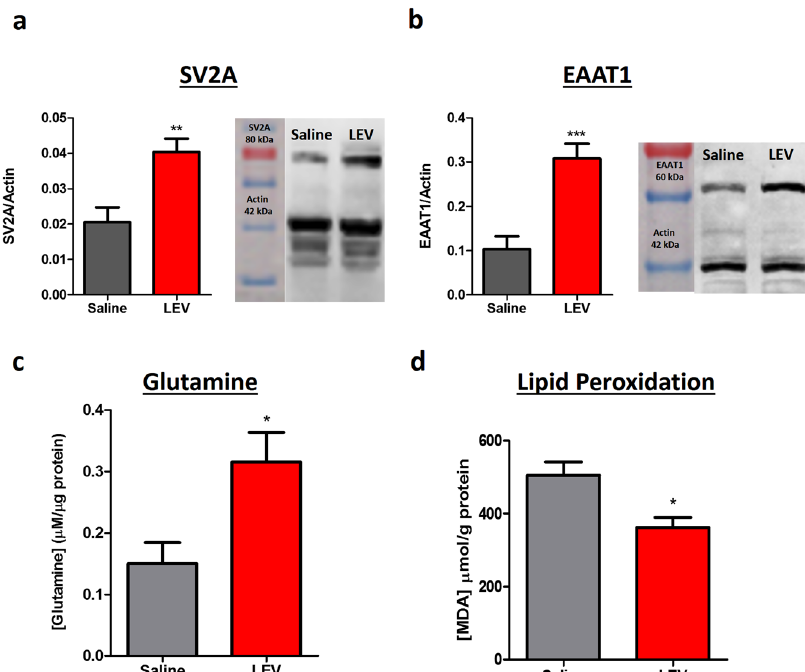
Fig. 3 LEV treatment promotes neuroprotection by modulating glutamate excitotoxicity and reducing lipid peroxidation. a LEV treatment led to a statistical signi fi cant increase of SV2A on the spinal cord tissue. b LEV also promoted a signi fi cant increase of EAAT1 on the spinal cord tissue. c LEV treatment increased glutamine tissue concentration 24 h post injury. d LEV promoted a signi fi cant reduction of lipid peroxidation on spinal cord tissue 24 h post injury. Saline n = 6; LEV n = 6. Values shown as mean ± SEM. * p < 0.05; ** p < 0.01; *** p <